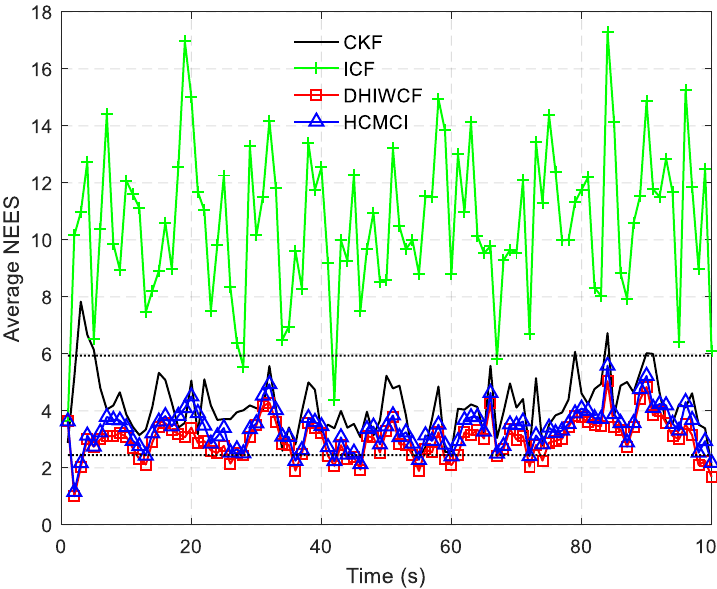
Figure 16. The averaged NEES for different algorithms in a spare sensor network.